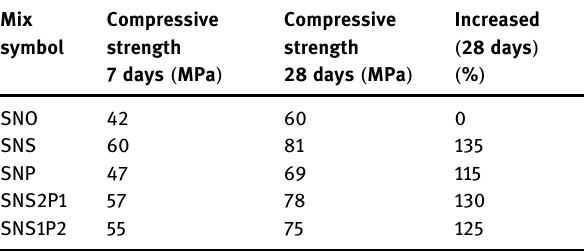
Table 3: Compressive strength